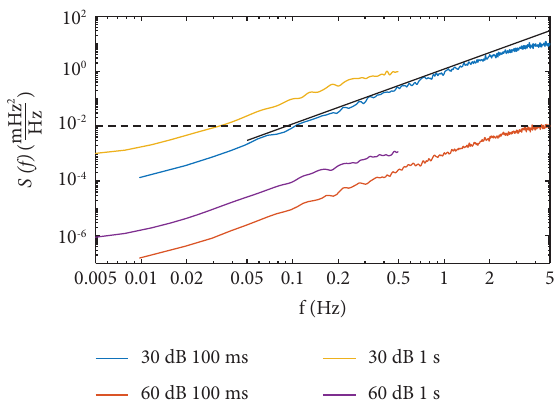
Figure 9: Power spectral density of f for the partial period zero- crossing method. Input is a sine wave with the additional white noise of diferent levels. PSD estimates saturate for a long period duration and rise nearly quadratic (solid black line) towards shorter periods. For 60dB SNR the dashed line indicates the maximum level of S ( f ) at 0.01mHz 2 · Hz − 1